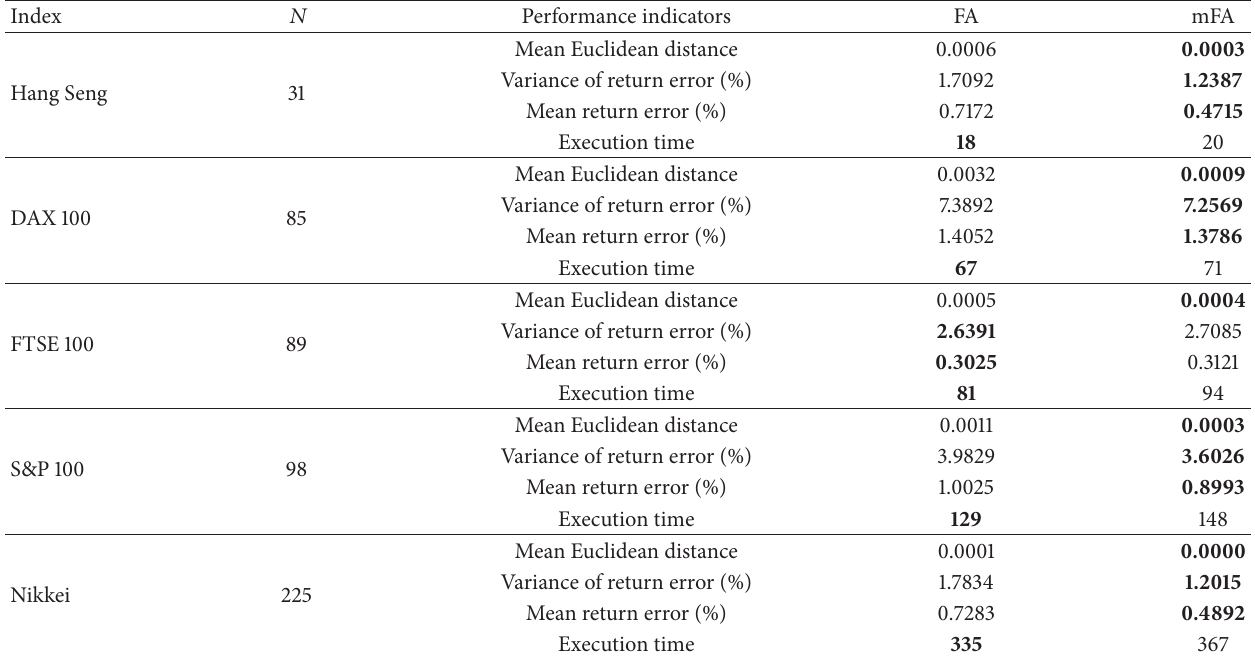
Table 3: Experimental results of FA and mFA for CCMV model.